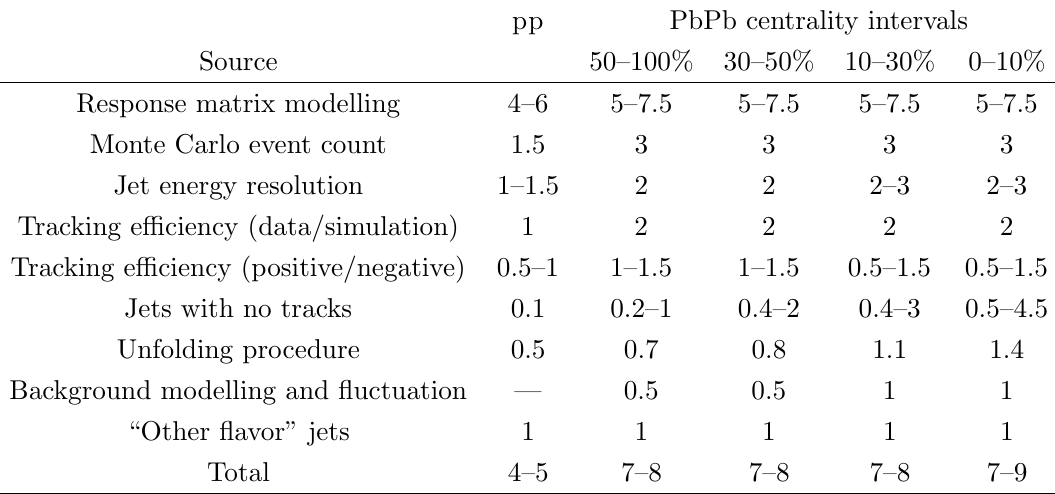
Table 1 . Relative systematic uncertainties in percentage for the measurements of gluon-like jet fractions in pp and PbPb events. The PbPb results are given in intervals of centrality. When an uncertainty range is given, the range of the values are the maximum variation in the fractions for di(cid:11)erent selections on (cid:20) and track p threshold T